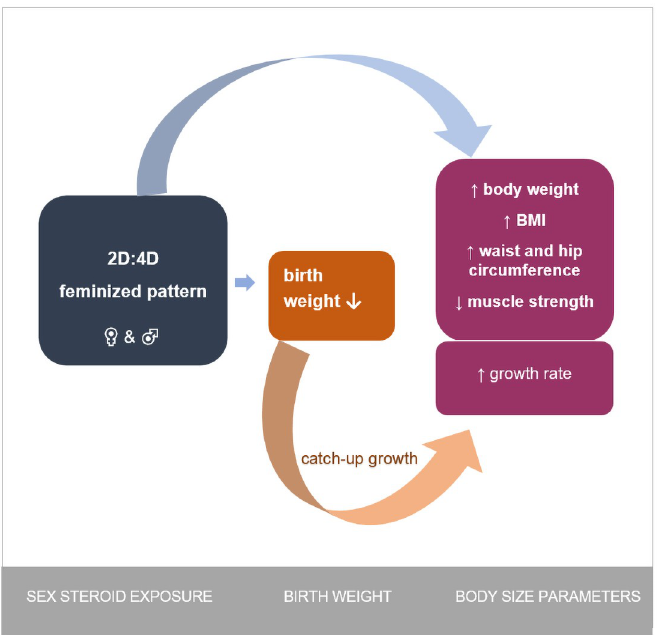
Fig 5. Interactions between prenatal sex steroid exposure and the processes shaping birth weight and body size parameters (blue arrows).